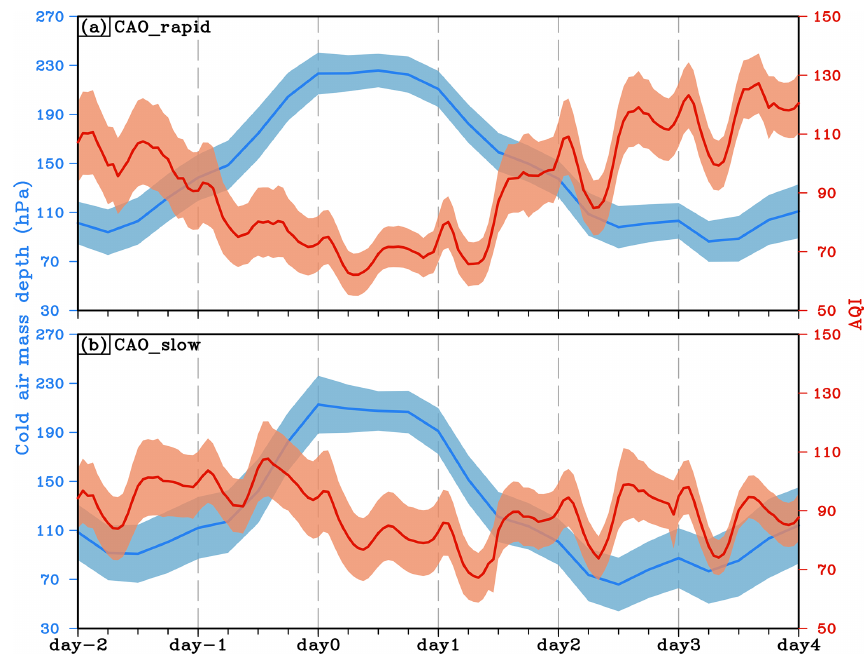
Figure 4. Evolutions of the spatially averaged (NEC at 114–122 ◦ E, 30–40 ◦ N) cold air mass depth and AQI during CAOs. Panels (a) and (b) are composited by the CAO_rapid events and CAO_slow events, respectively. Blue lines and red lines denote the cold air mass depth and AQI, respectively. Shading represents the 95% confidence interval of the composited mean value.